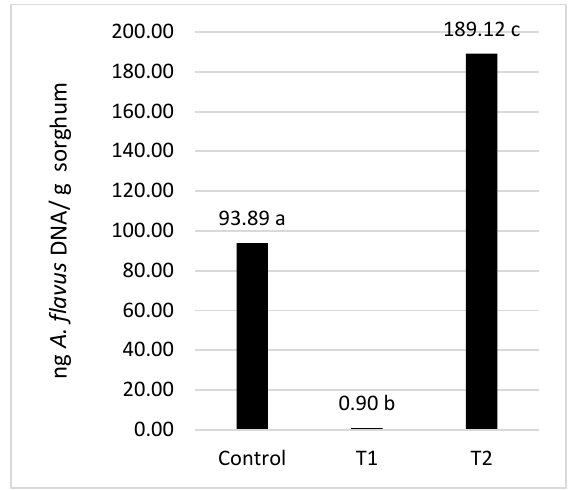
Figure 2. Nanograms (ng) of A. flavus DNA per sorghum weight obtained from the control (sterile water), T1 (water kefir), and T2 (filter-sterilized water kefir) treatments. Values labeled with different letters are significantly different, as calculated by a LSD Fisher Test α = 0.05.